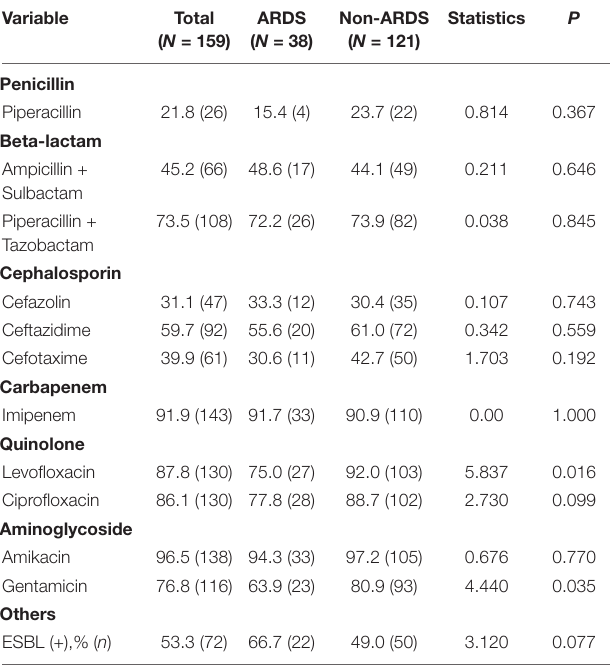
TABLE 4 | Rates of Gram-negative bacteria susceptibility to different antibiotics [% ( n )]. Variable